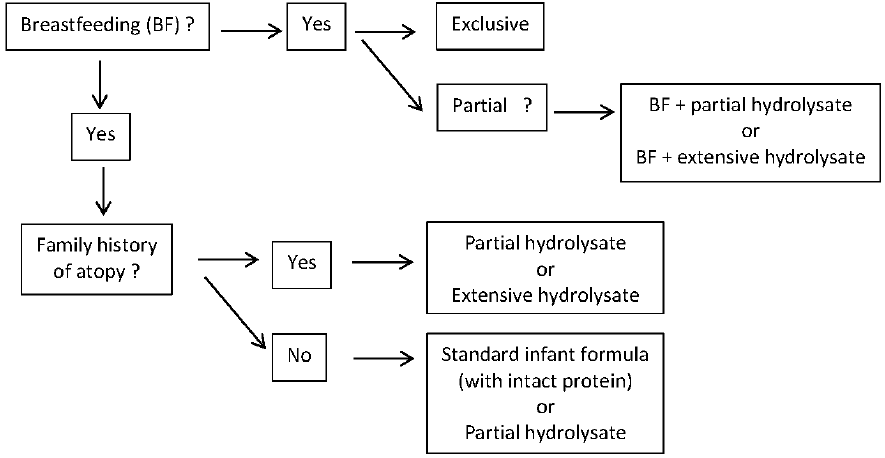
Figure 1. Proposed dietary options according to breastfeeding and/or family history of atopic disease.